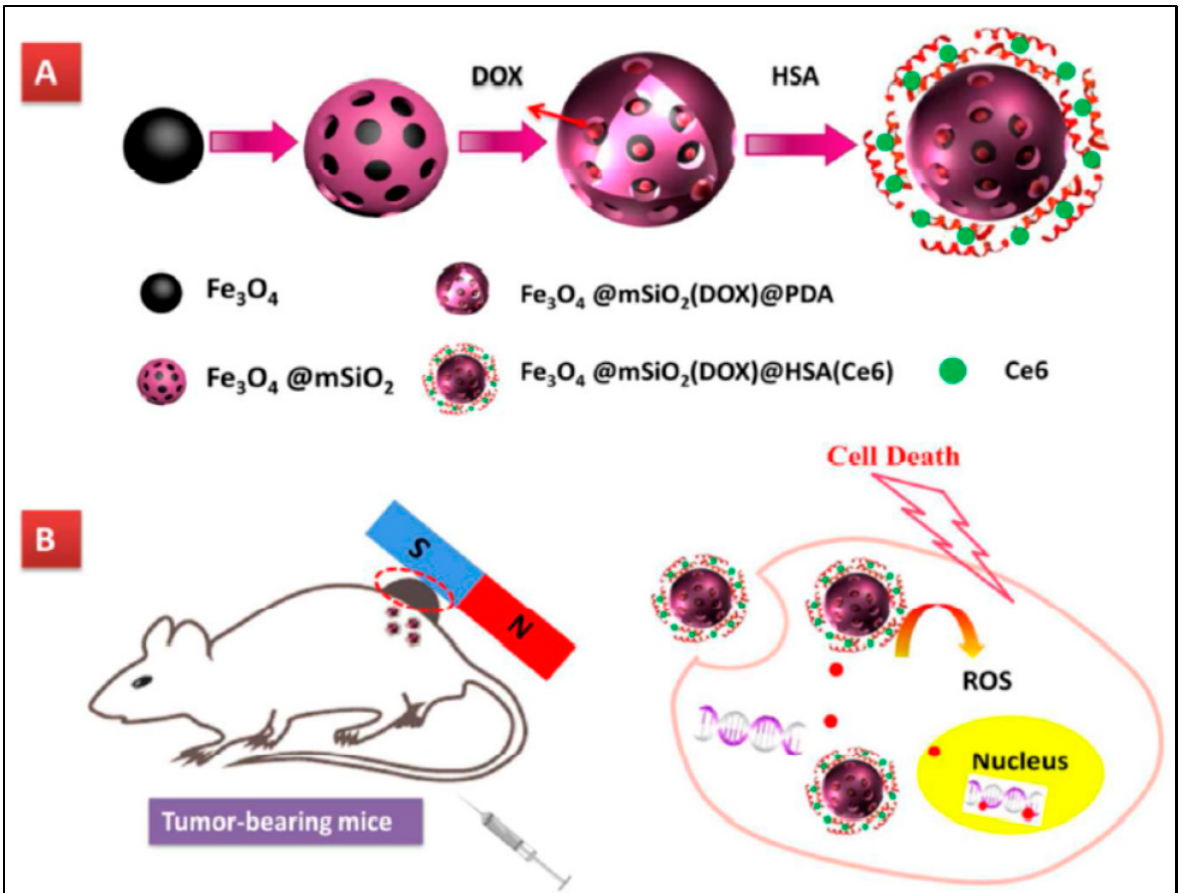
Figure 7. ( A ) A schematic illustration of the Fe 3 O 4 @mSiO 2 (DOX)@HSA(Ce6) synthesis process. ( B ) The schematic illustration of the application of Fe 3 O 4 @mSiO 2 (DOX)@HSA(Ce6) nano-platform in cancer therapy. Human serum albumin: HAS. Reproduced with permission from [92], ACS, 2018. Application of Graphene in